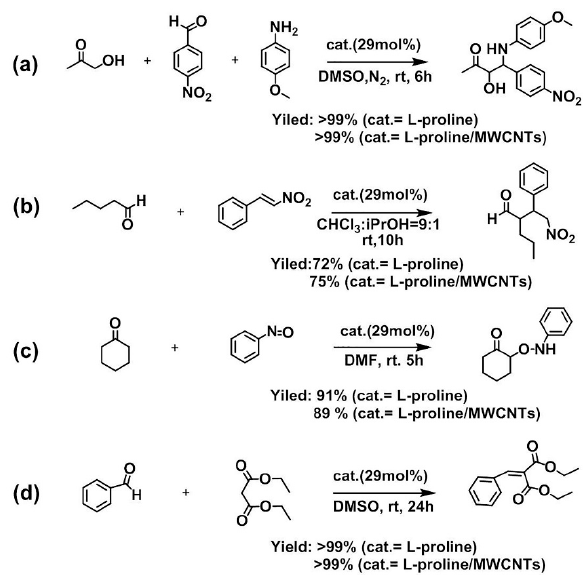
Figure 6. Application of the L-proline/MWCNTs catalyst in ( a ) Mannich reaction, ( b ) Michael reaction, ( c ) α -oxyamination reaction, and ( d ) Knoevenagel condensation.